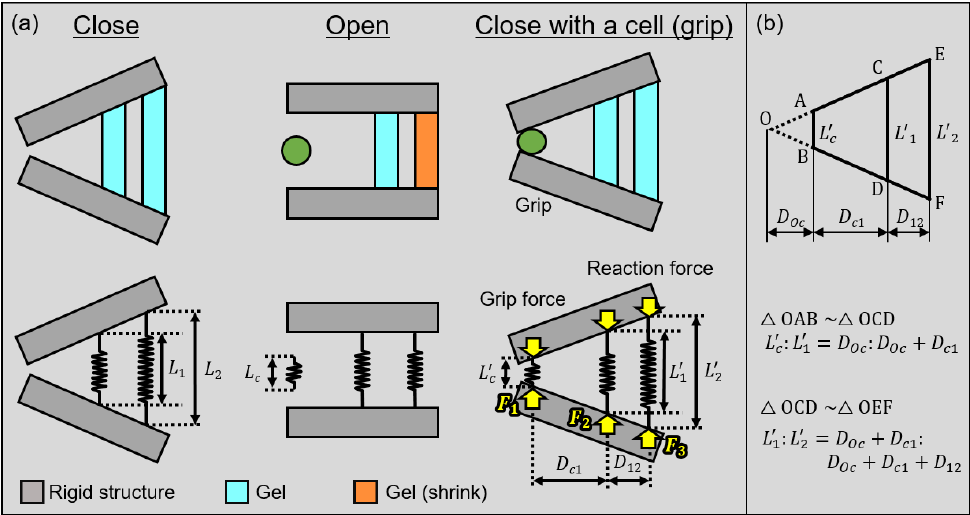
Figure 2. Mechanical model of the microgripper: ( a ) models of each state; and ( b ) similarity